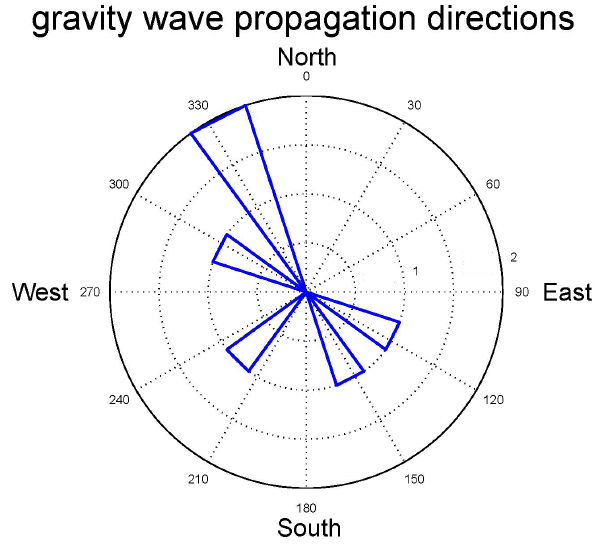
Fig. 12. Polar diagram of gravity wave propagation directions. The radial scale denotes the number of events per angular bin.